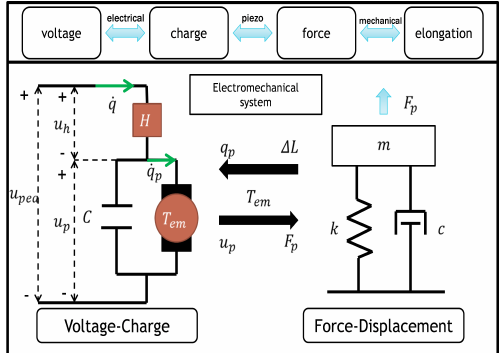
Fig. 2: Electromechanical representation of the piezo- electric actuator.